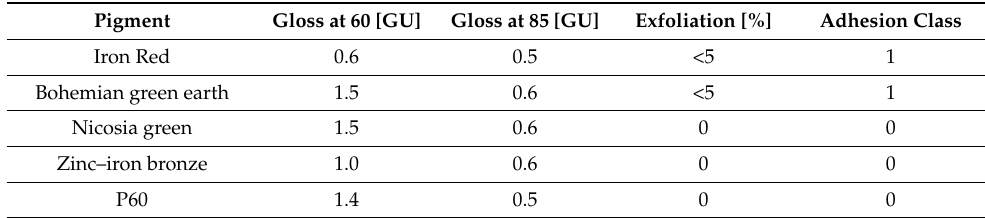
Table 1. Effects of pigments on gloss, exfoliation, and